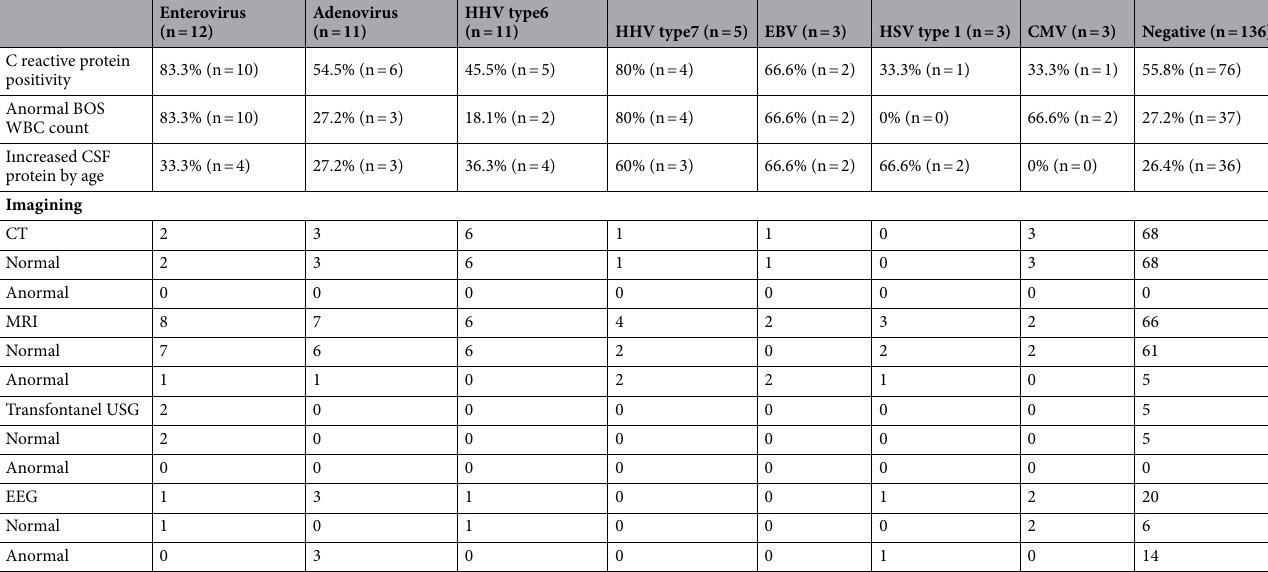
Table 2. Distribution of C-reactive protein and CSF laboratory findings and Evaluation of imaging results. HHV Human Herpes Virus, CMV Cytomegalovirus, HSV Herpes Simplex Virus, EBV Ebstein Barr Virus,